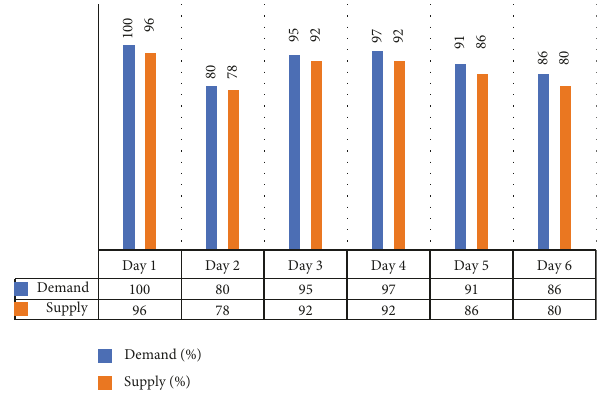
Figure 5: Demand supply optimization.